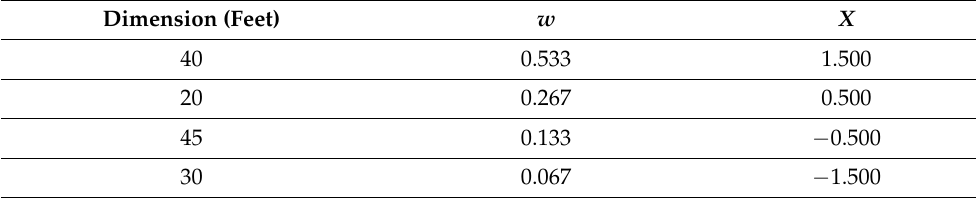
Table 6. Ranking of the container dimension categories according to retention time.